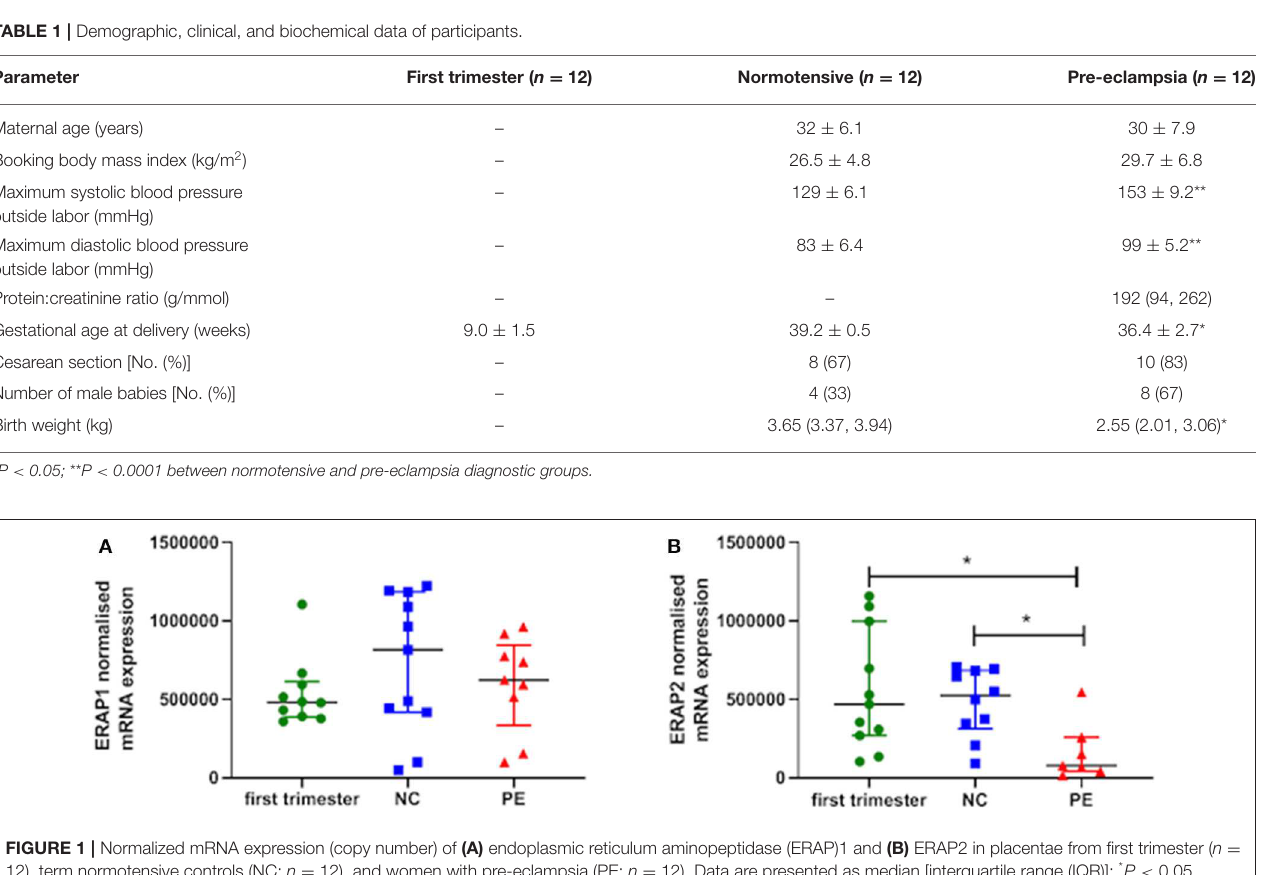
observed for ERAP1 between groups ( P > 0.05; Figure 1A